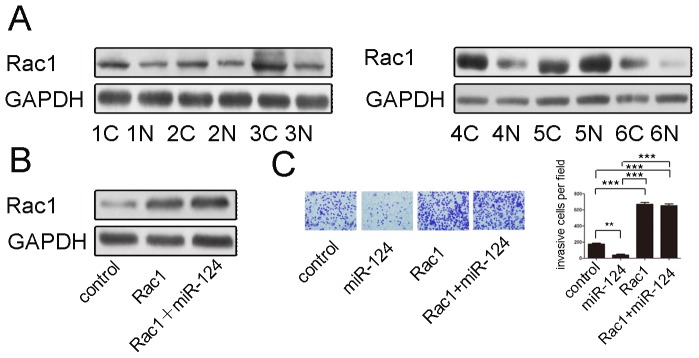
Overexpression of Rac1 inpairs miR-124-induced inhibition of invasion in MG-63 cells.(A) Rac1 is over-expression in osteosarcoma tissues. Western blot analysis of Rac1 protein expression in six patients whose miR-124 expression was down-regulated in osteosarcoma tissues. (B) Overexpression of Rac1 incresed Rac1 protein expression. (C) MG-63 cells were transfected with miR-124 mimics and/or Rac expression vector, and transwell invasion assay was performed. Overexpression of Rac1 inpairs miR-124-induced inhibition of invasion. All data is shown as mean±SD. *p<0.05, **p<0.01 and ***p<0.001.